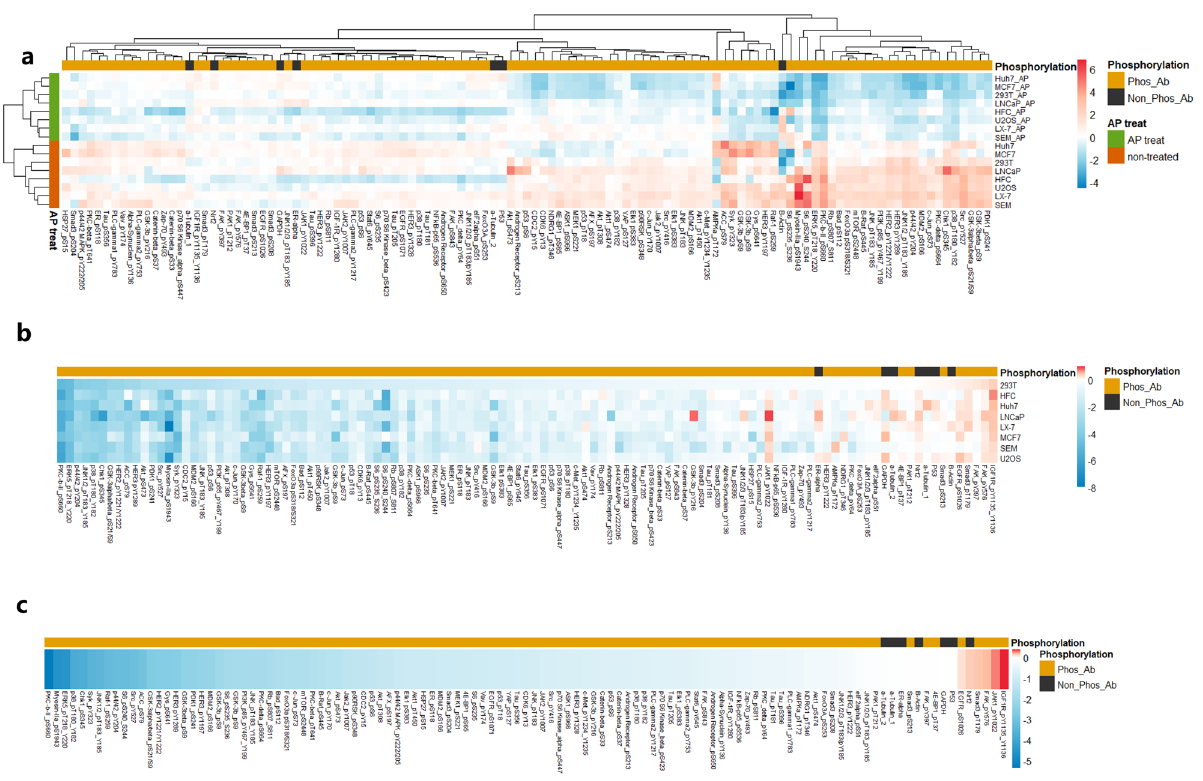
Figure 1. Assessment of alkaline phosphatase treatment induced effect across 8 cell lines versus non-treated controls. ( a ) Unsupervised hierarchical clustering of lysates generated with AGLyse with or without additional AP treatment across 8 cell lines (SEM, LX-7, U2OS, HFC, LNCaP, 293T, MCF7 and Huh7). Phospho-antibodies are marked in yellow and total antibodies (non-phosphor) are marked in black. ( b ) LogFC reduction level of individual antibodies across cell lines. Individual target LogFC is ranked by 293T cells from the lowest to highest (left to right) and rest of cell lines are matched according to LogFC positions of individual targets. c. Averaged logFC across 8 cell lines and data are ranked from lowest to highest (left to